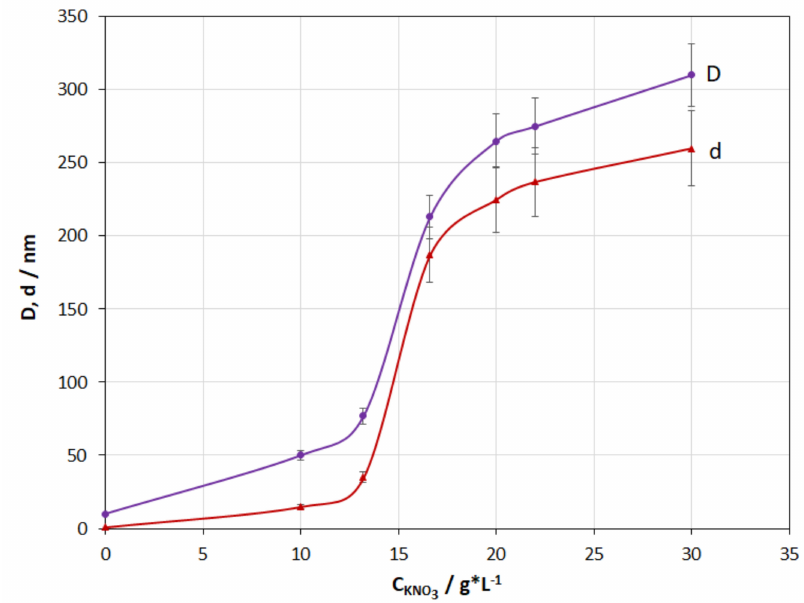
Figure 4. Dependence of the average coating thickness (D) and average particle size (d) on the salt concentration (C KNO3 ) in the reaction medium.